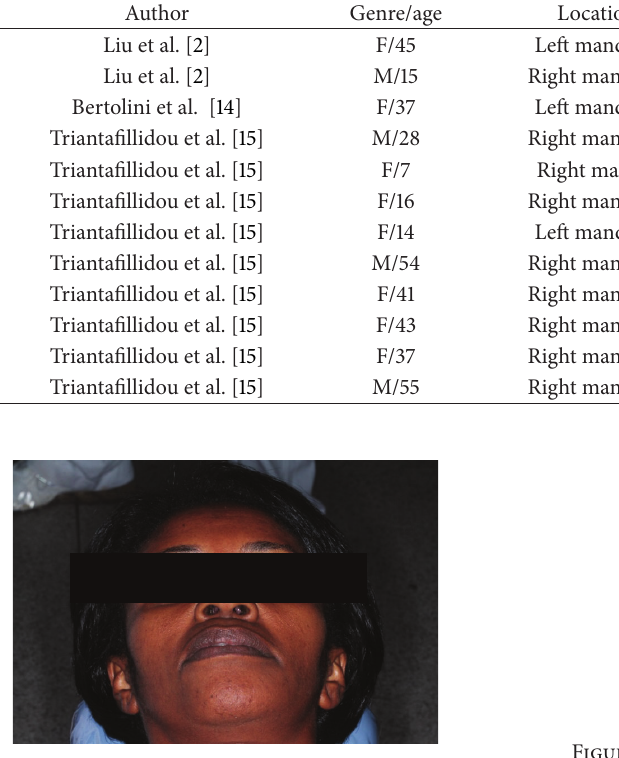
Figure 1: Preoperative clinical appearance of the patient.